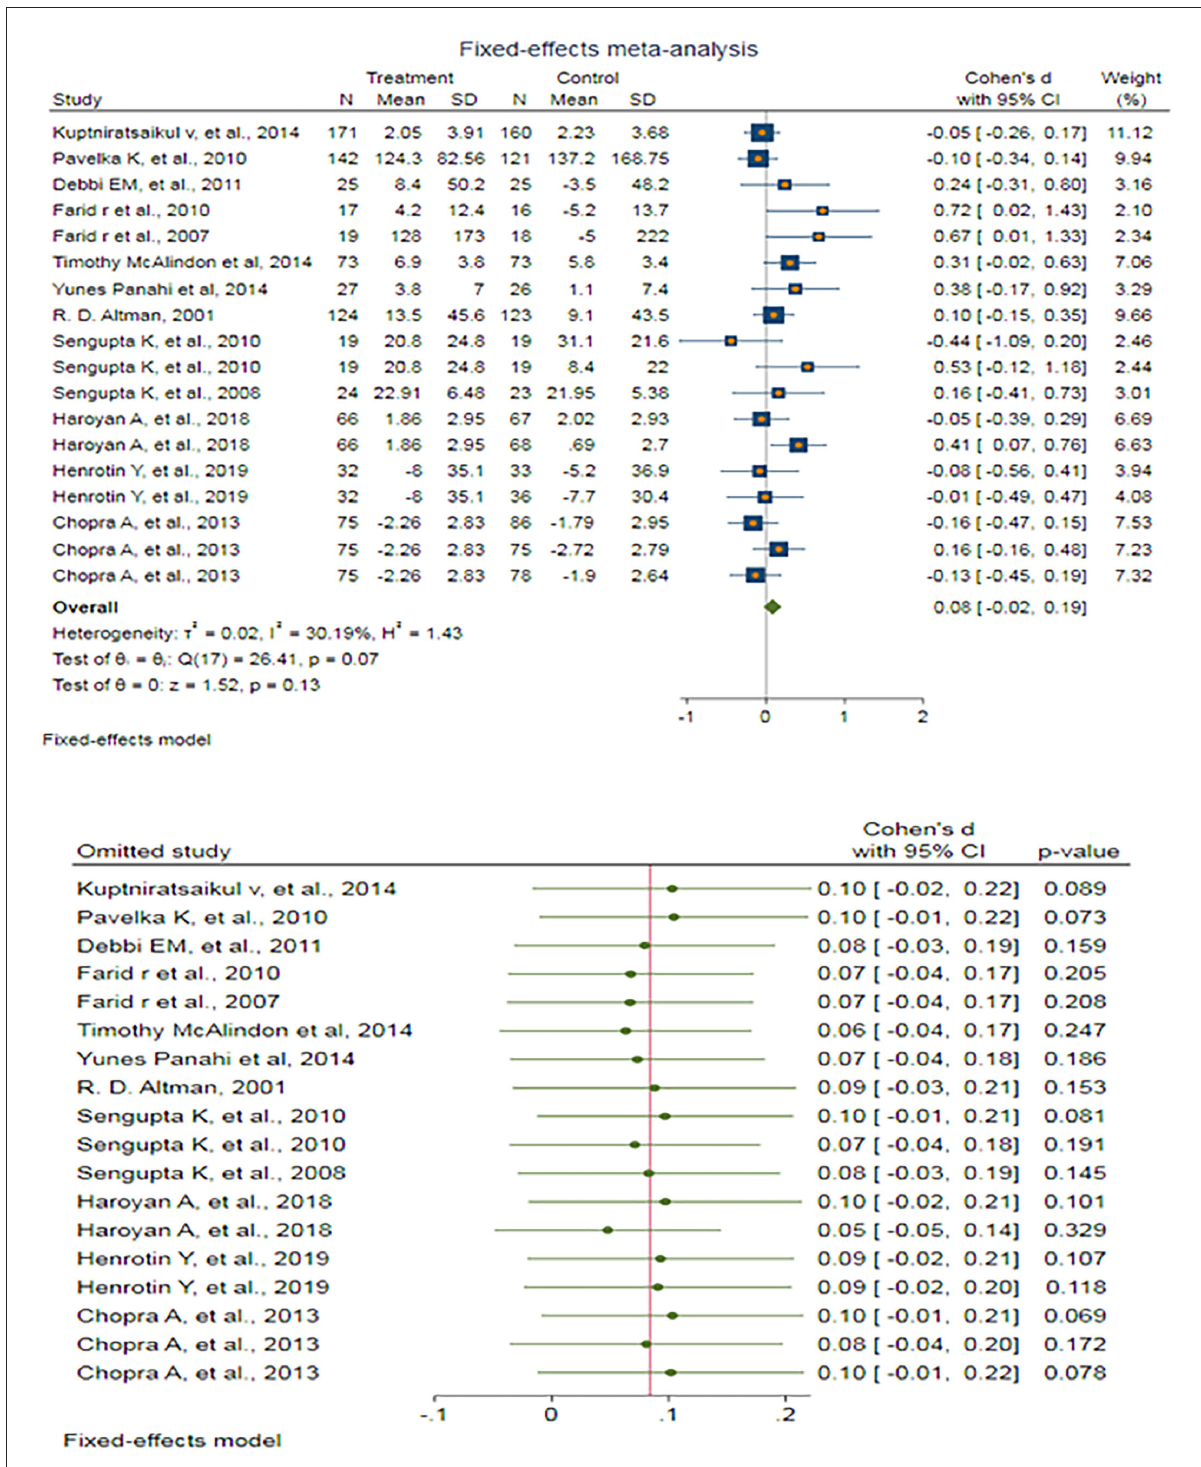
FIGURE5 (UP) A forest plot for the association between antioxidants and the outcomes of interest in OA based on the WOMAC pain score. (DOWN) Forest plot of sensitivity analysis for the association between antioxidants and the outcomes of interest of OA based on the WOMAC pain